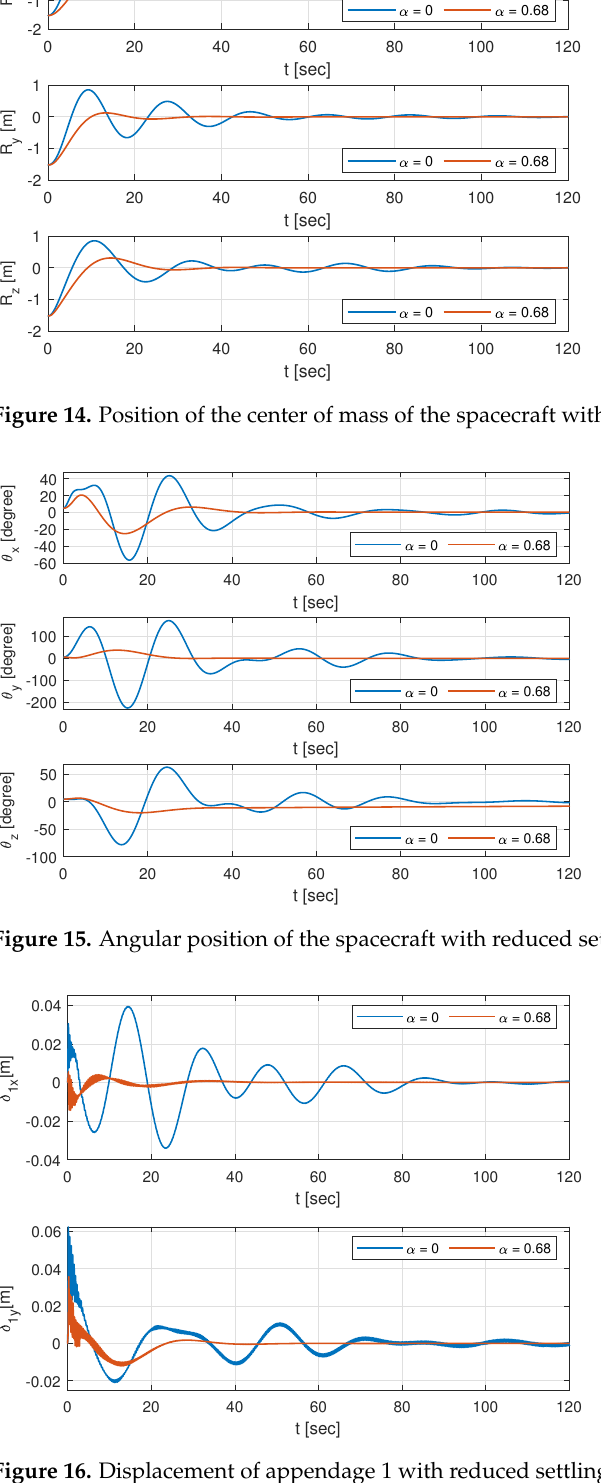
Figure 16. Displacement of appendage 1 with reduced settling